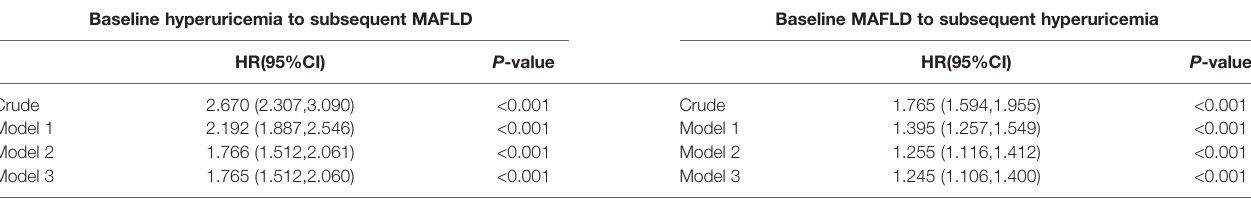
MAFLD, metabolic dysfunction-associated fatty liver disease. Model 1: adjusted for age and sex.